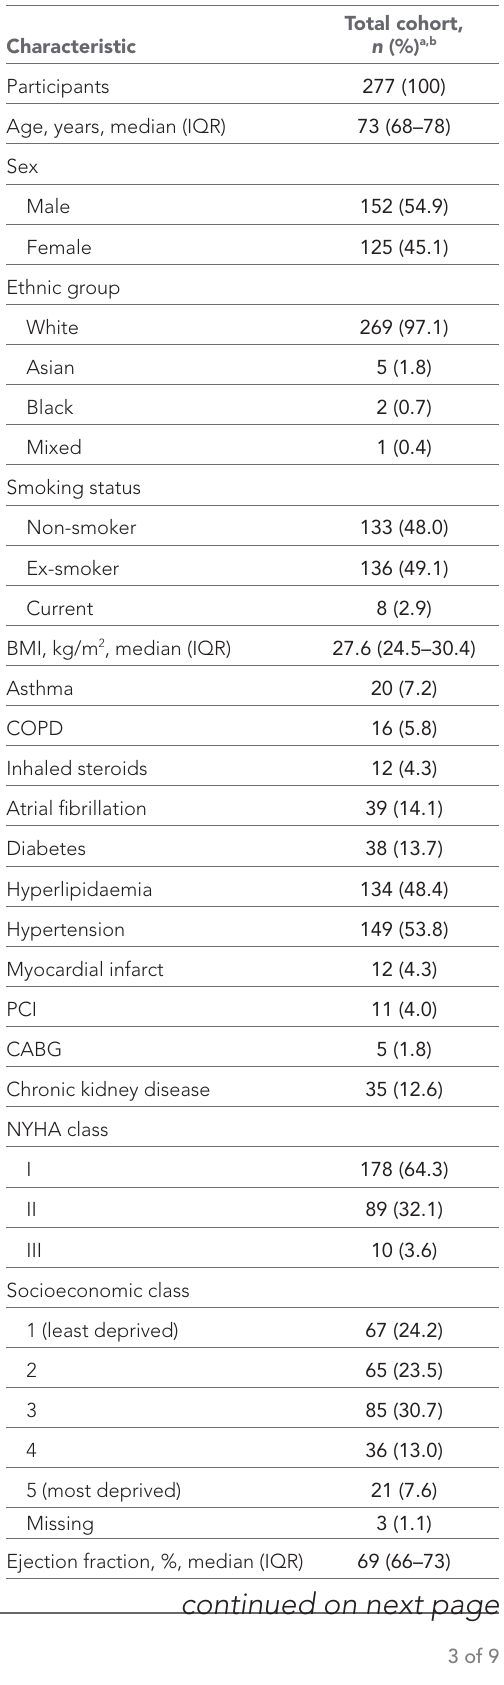
Table 1 Clinical characteristics, heart failure